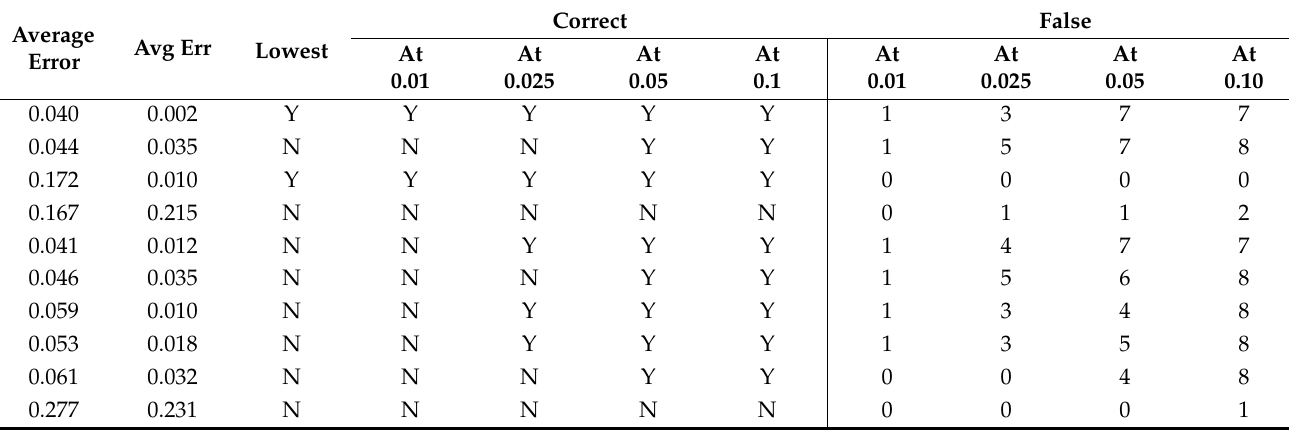
Table A16. Set 1, trials 1–10 summary data (average actual PR